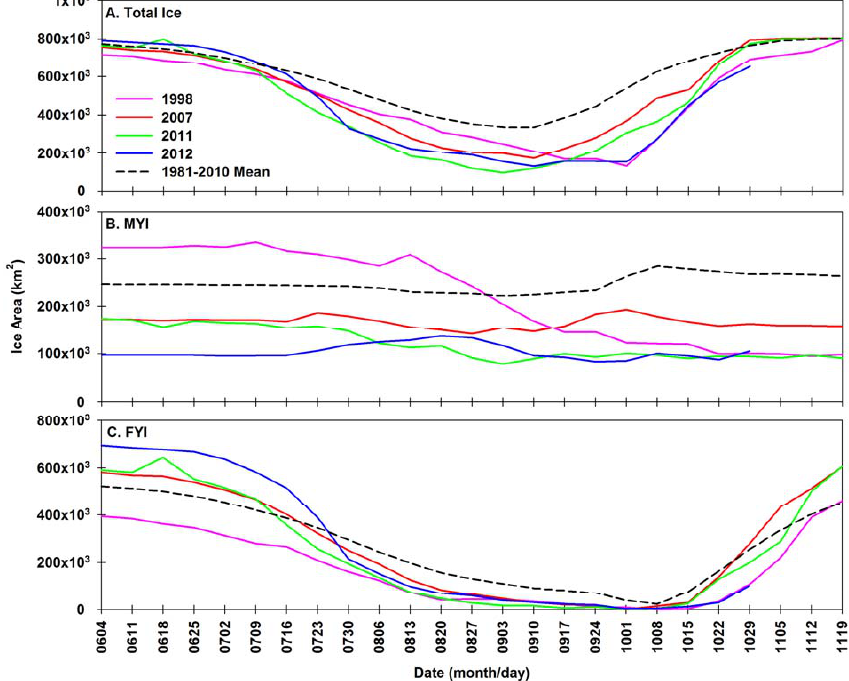
Figure 5. Weekly time series of total ice (A), multi-year (MYI) (B) and first year ice (FYI) (C) area (km 2 ) for 1998, 2007, 2011 and 2012 in the Canadian Arctic Archipelago.